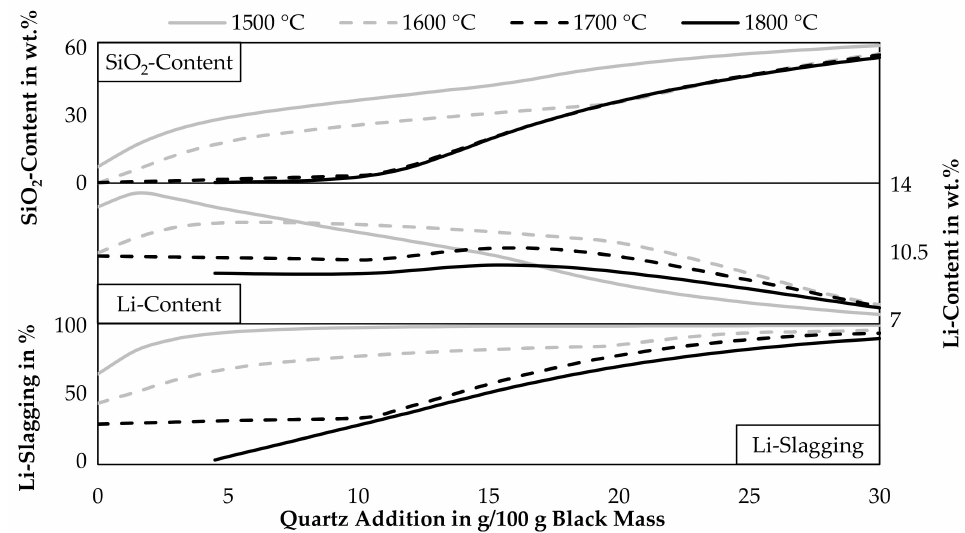
Figure 8. Influence of temperature and quartz addition on the SiO 2 - and Li-content in slag and Li-slagging with a CuO-addition of 65 g per 100 g black